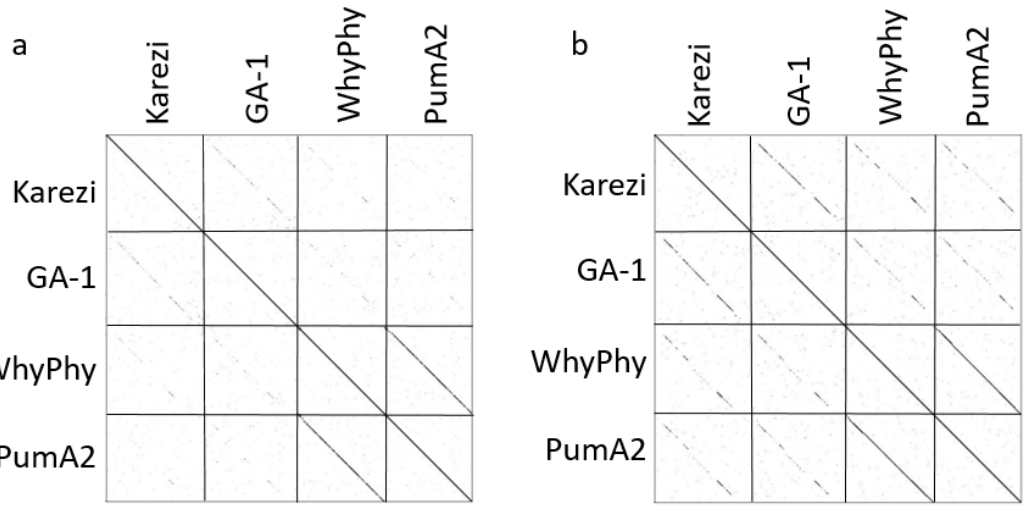
Figure 5 . Whole genome and proteome comparison by dotplot. Whole genome (panel a , word size = 12) and whole proteome (panel b , word size = 4) sequences are compared against themselves.